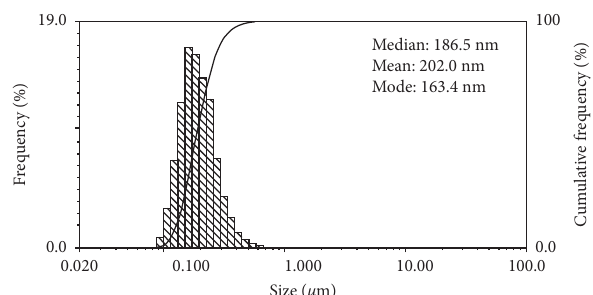
Figure 2: DLS size distribution of CuNPs in solution after 90 min of reaction.